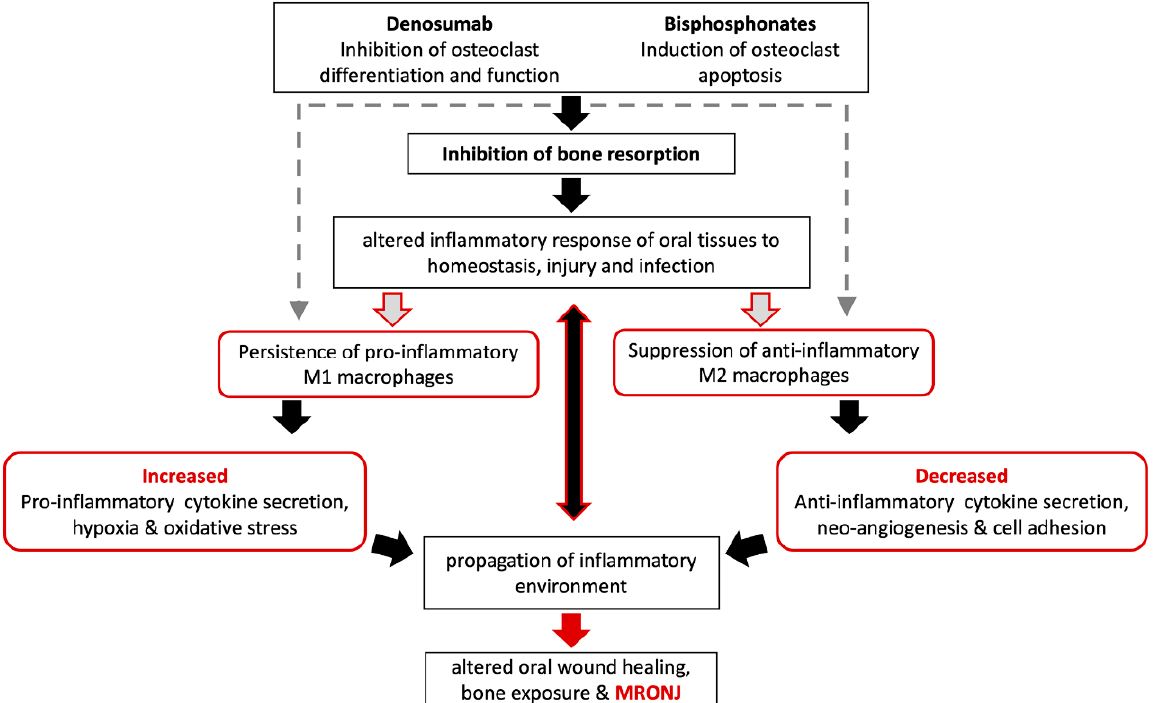
Figure 2. In vivo potential antiresorptives’ effect on macrophages’ Inhibition of bone resorption is central in Medication-Related Osteonecrosis of the Jaw (MRONJ) pathogenesis. Changes in macrophage polarization and function are likely in response to a sustained inflammatory environment and propagate the MRONJ extent and severity. Red color were used to highlight pathways and processes related to macrophahe biology that potentially contribute to MRONJ development.